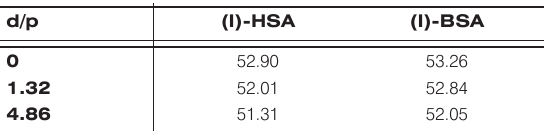
Figure 11. CD spectra of A) the HSA–(I) system; [HSA] = 0.75×10 -6 M; B) the BSA–( I ) system; [BSA] = 0.75×10 -6 M; 1-4: d/p = 0; 1.32; 2.98; 4.86, respectively. T=298 K, pH =7.4. 2.72Energy α - helix content of HSA and BSA at different dye/protein molar